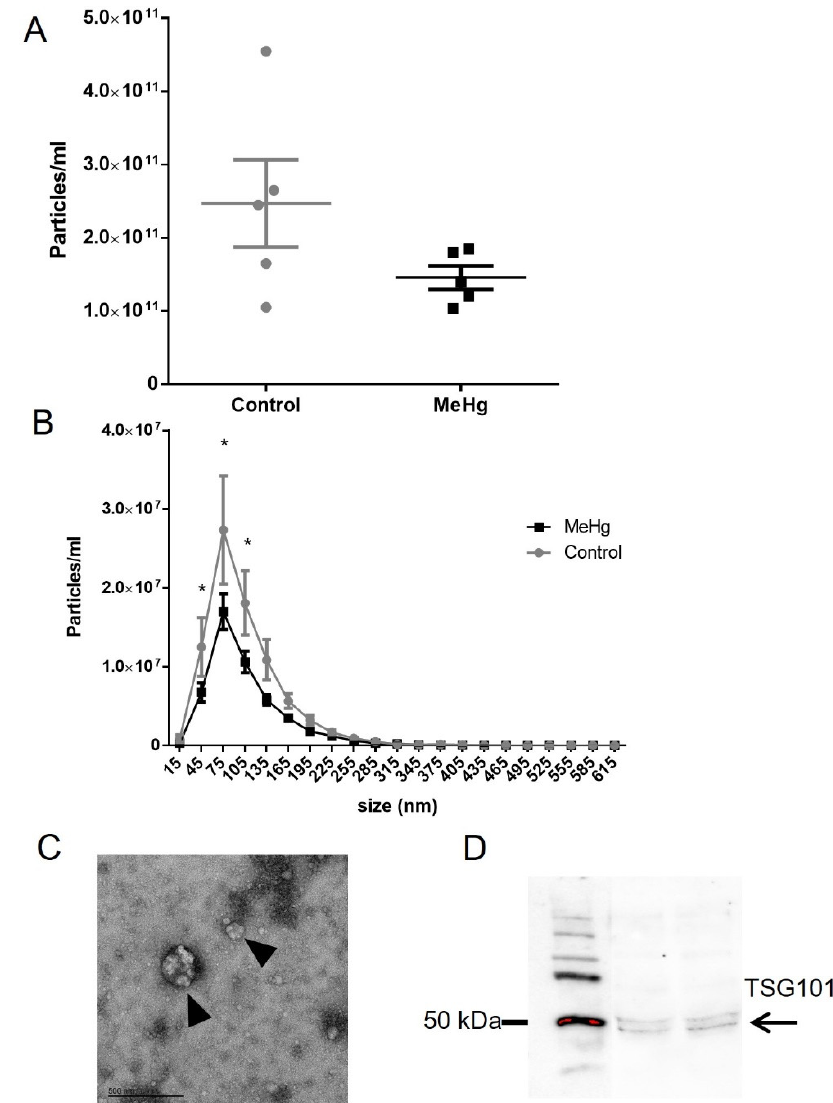
Figure 4. Effects of methylmercury (MeHg) in circulating plasma extracellular vesicles (EVs). Rats were orally exposed to water (Control) or MeHg 5 mg/kg (MeHg) for four consecutive days and EVs were isolated from plasma: ( A ) total number of EVs (each dot representing each treated animal); ( B ) number of smaller EVs (45, 75, and 105 nm); ( C ) representative electron micrograph (scale bar of 500 µm) showing the detected EVs (black arrow head); and ( D ) western blot showing that EVs were immunopositive for the TSG101 (black arrow), a protein marker of EVs. EVs isolation was performed 24 h after the last dose of treatment. Results are expressed as mean ± SEM. n = 4–5 per group. Student t test (A) and two-way ANOVA (B), * p < 0.05 vs. control.